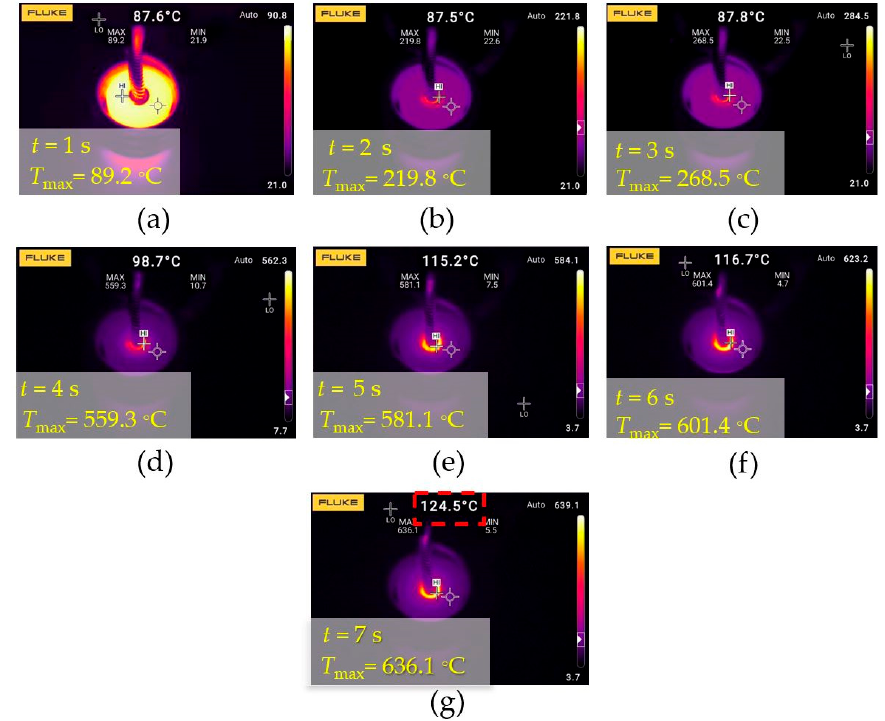
Figure 12. The temperature distribution on the product’s surface ( a – g ) for times of 1–7 s from experiment #2.